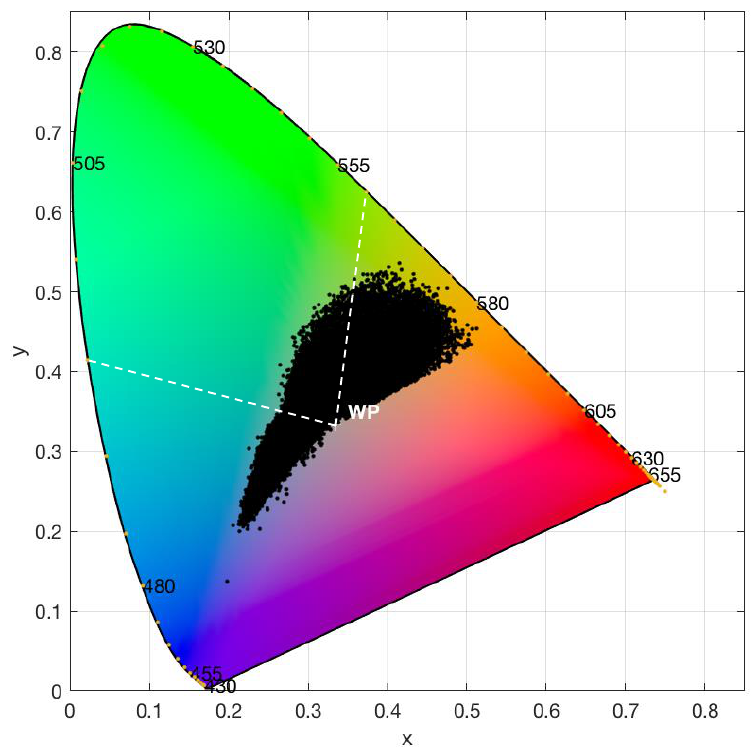
Figure 7. Chromaticity diagram showing the water colour of 44,947 lake observations determined from Landsat 8 OLI data. The dashed lines from the white point (WP) to dominant wavelengths of 495 and 510 nm, respectively, indicate the nominal boundaries for colour classification into blue, green and red bins.